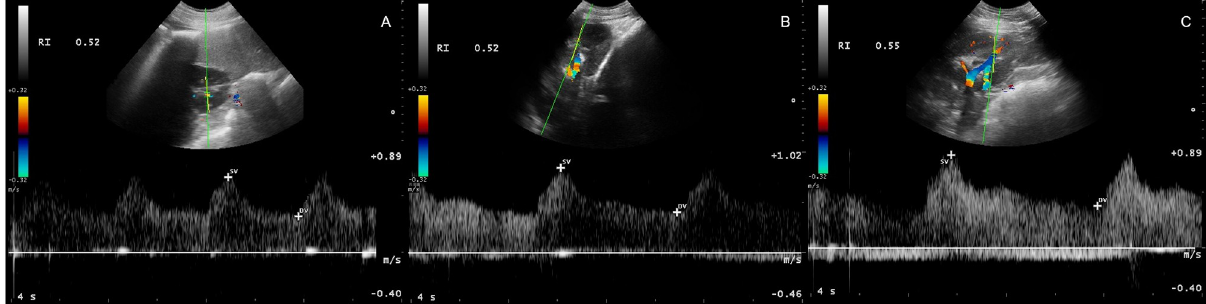
Fig 2. The pulsed-wave Doppler flow and resistive index measurement of intrarenal vessel of (A) foal, (B) adult horse and (C) elderly